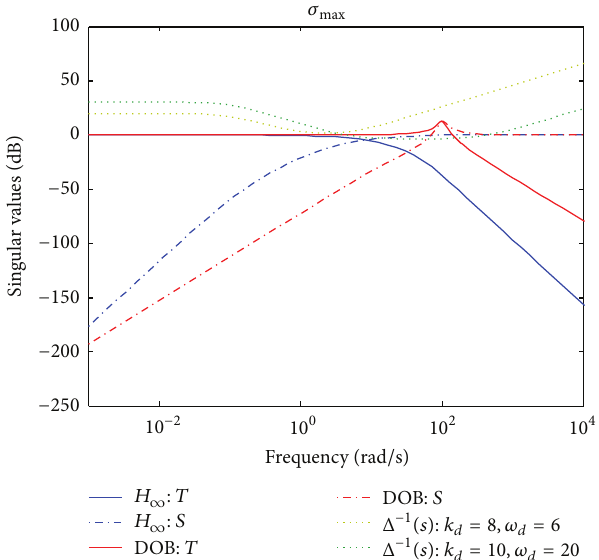
Figure 11: Robust stability and tracking